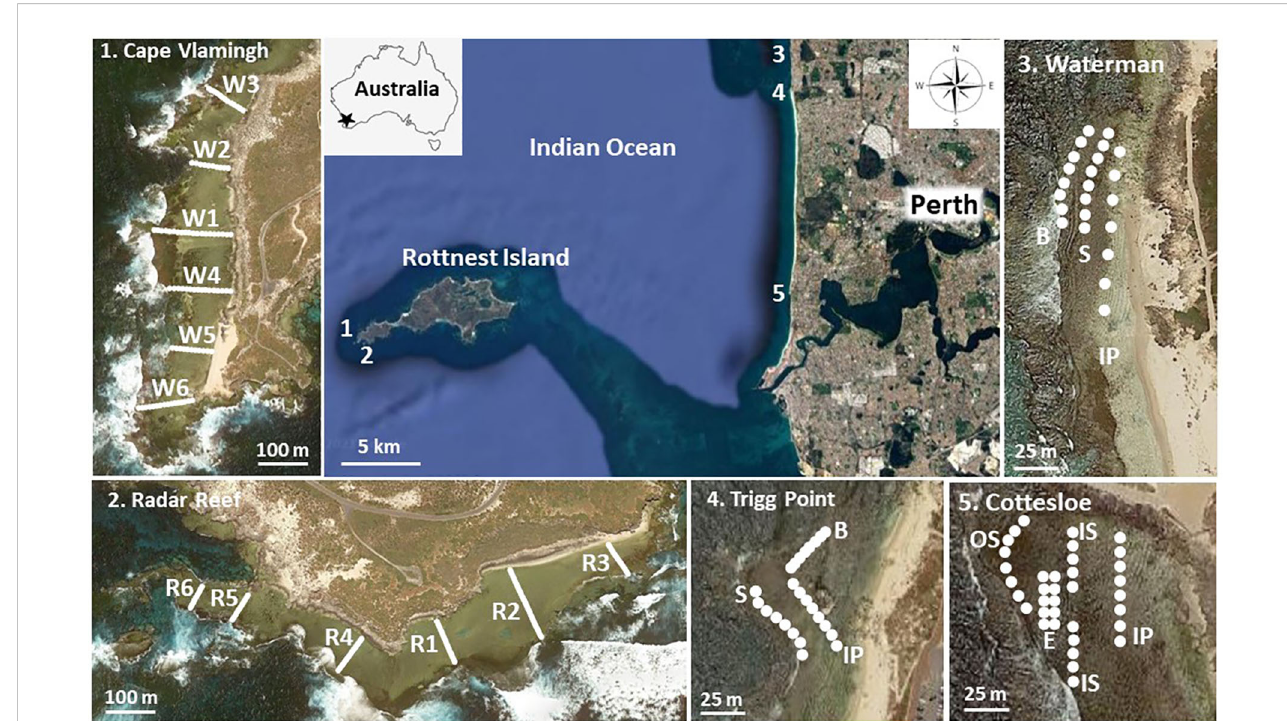
FIGURE 1 Map of the location of the study sites and transects at Rottnest Island and along the coastline of Perth, Western Australia. For the coastal platforms, habitat codes are IP inshore platform; S, Sargassum ; B, bare; IS, inner Sargassum ; OS, outer Sargassum ; E, Ecklonia ; Redrawn from Google